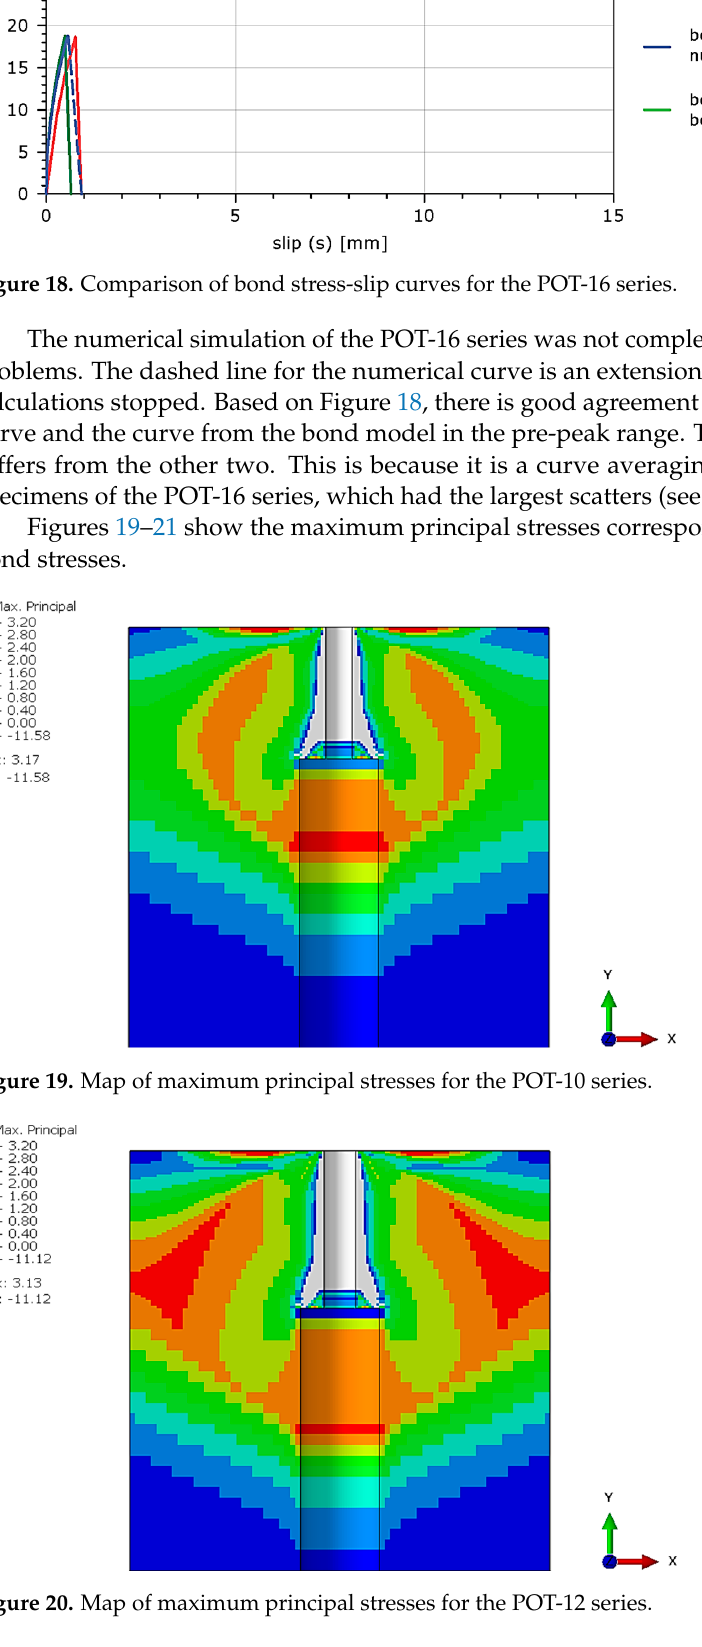
Figure 21. Map of maximum principal stresses for the POT-16 series. During the pull-out tests, the POT-16 series specimens were damaged by splitting, which is evident from the curve shown in Figure 14. This means that the vertical compo- nent of the bond force, causing radial compressive stresses in the cracked bar cover and circumferential tensile stresses in the uncracked bar cover [52], was dominant due to in- sufficient bar confinement in the concrete. This should lead to exceeding the concrete ten- sile strength and splitting the concrete. From the map of maximum principal stresses (maximum tensile stresses, Figure 21), the maximum tensile stress occurring in the speci- men had a value of 2.83 MPa, and at the edge of the block, about 2.40 MPa. Equal param- eter values for the concrete material model were used for the numerical analysis of the POT. Table 15 shows the mean concrete tensile strengths for each series of pull-out test. Table 15. Mean value of concrete tensile strength (f ctm ) according to pull-out test series (in MPa). POT-10 [MPa] POT-12 [MPa] POT-16 [MPa] 3.33 3.22